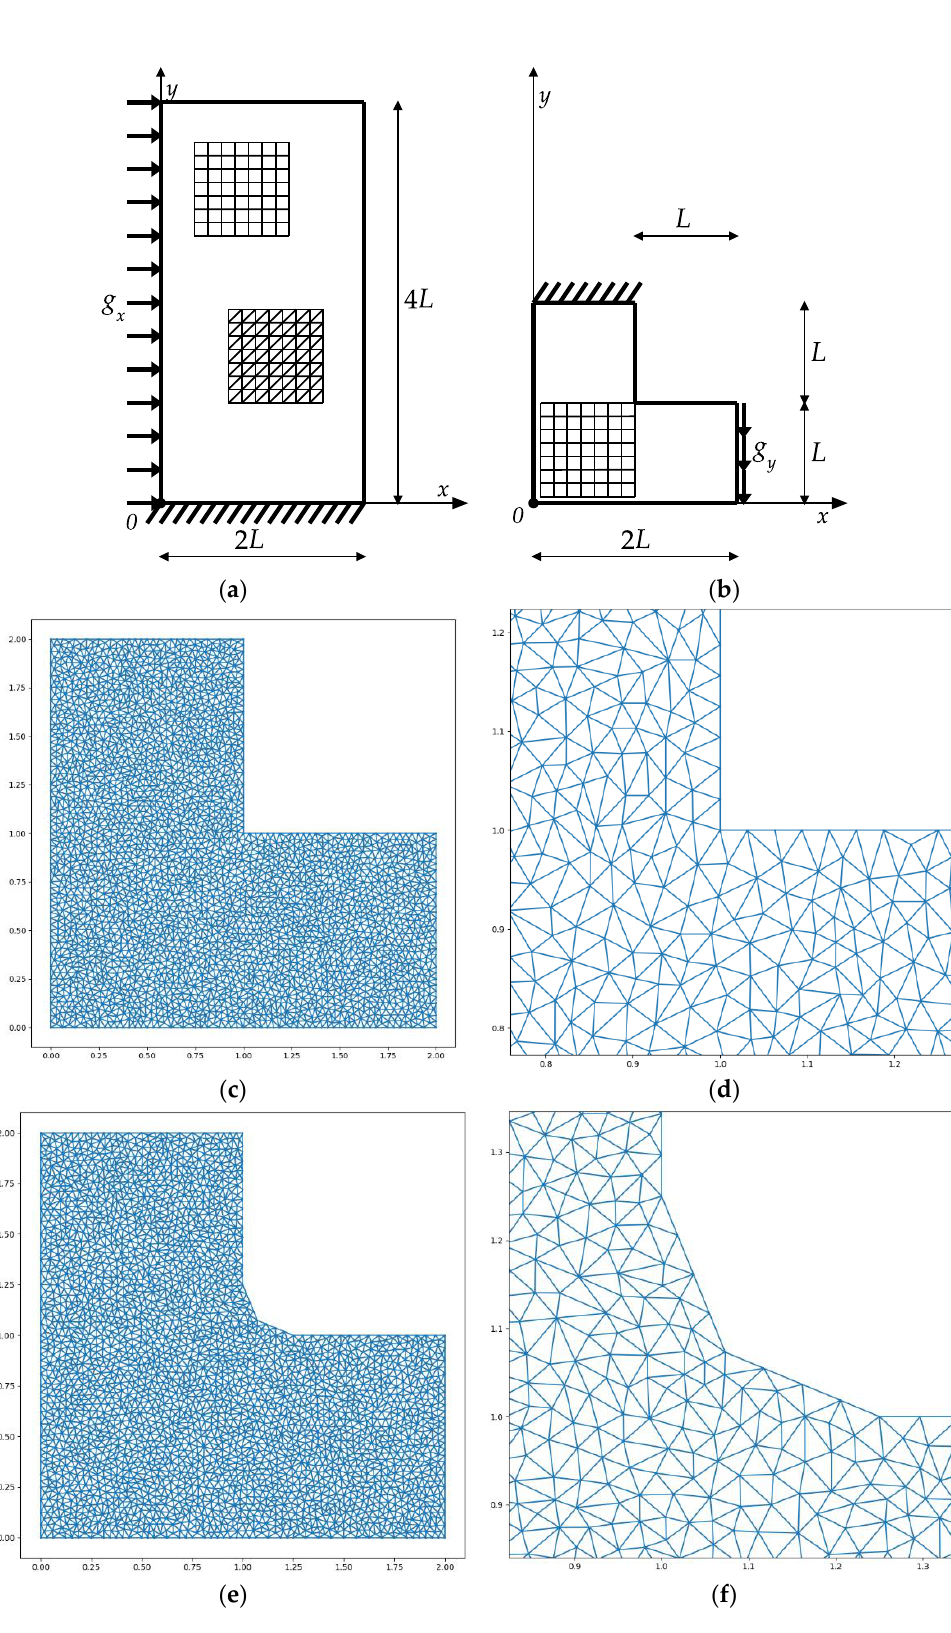
Figure 5. The vertical cantilever ( a ) covered by the regular quadrilateral and triangular FEM meshes and L -shaped cantilever ( b ) covered by the regular quadrilateral FEM mesh. The irregular FEM meshes ( c , e ) of triangular finite elements along with the enlarged fragments ( d , f ) around the reentrant corner covering two variants of the L -shaped cantilevers,